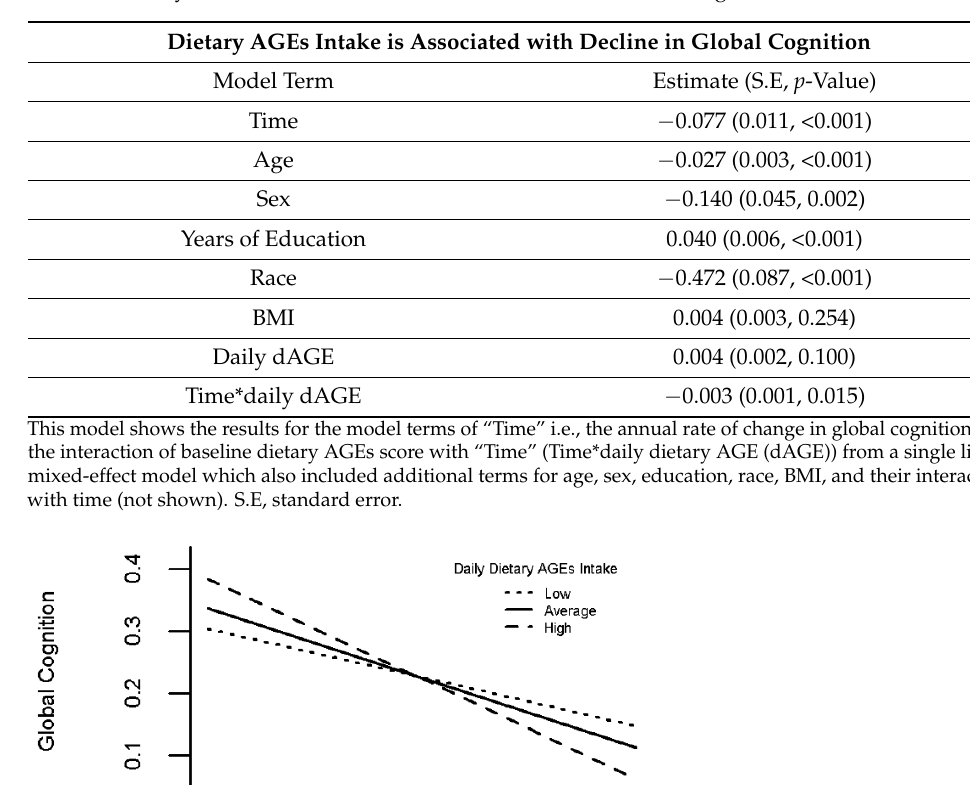
Table 2. Dietary AGEs intake is Associated with Decline in Global Cognition.